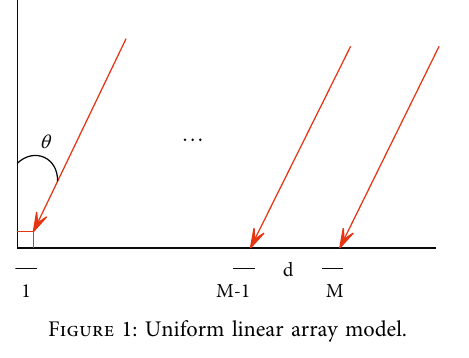
Figure 1: Uniform linear array